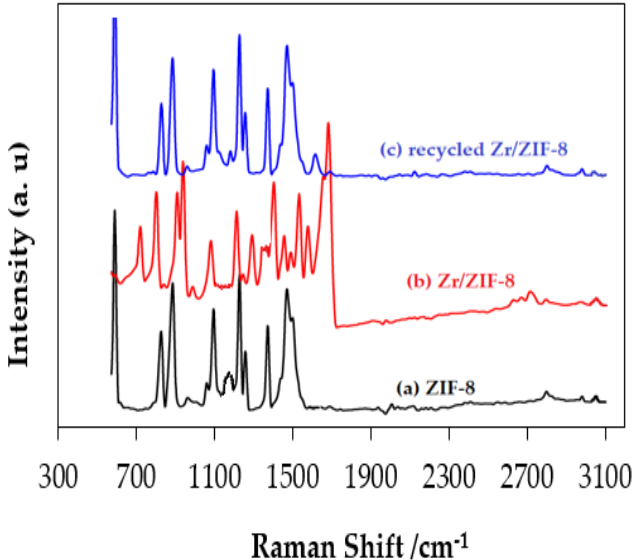
Figure 10. Raman spectra of the crystal-size ( a ) ZIF-8, ( b ) Zr / ZIF-8, and ( c ) recycled Zr / ZIF-8 samples.